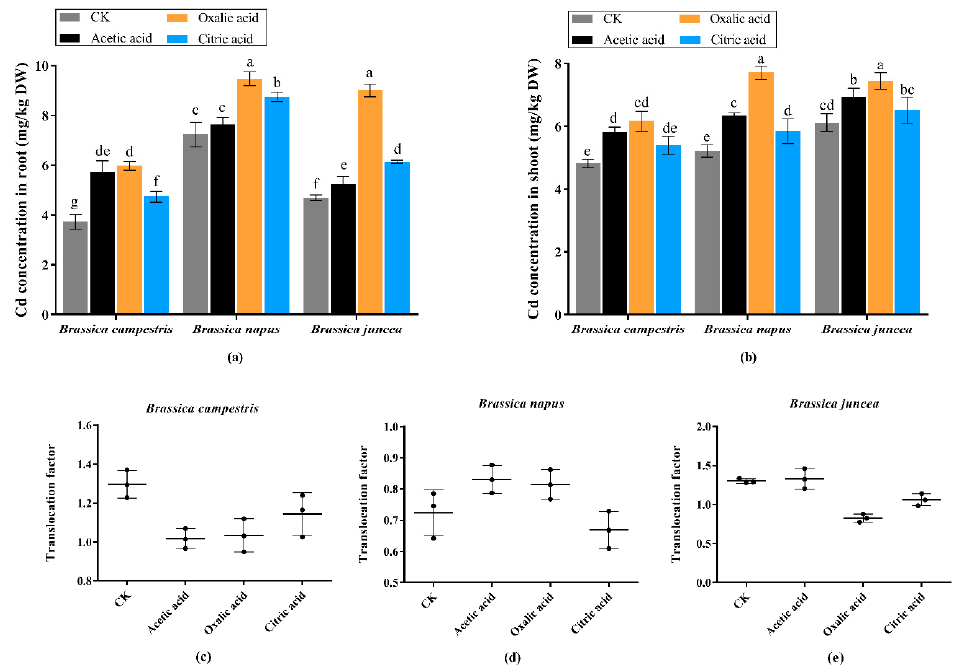
Figure 5. Cd concentration in three Brassica species at seedling stage. The Values are means + SE from three biological replicates. Values followed by different letters indicate statistical significance based on two-way ANOVA ( p < 0.05). ( a ) Cd concentration in root. ( b ) Cd concentration in shoot. ( c ) Cadmium translocation factor in Brassica campestris . ( d ) Cadmium translocation factor in Brassica napus . ( e ) Cadmium translocation factor in Brassica juncea .